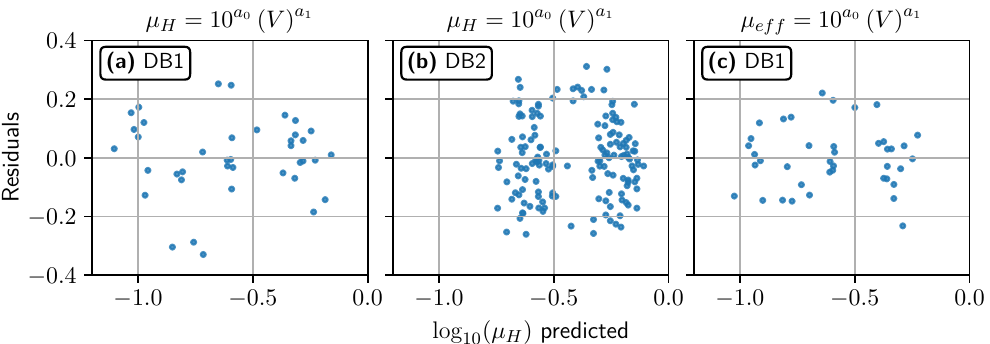
Figure A1. Residuals VS predicted values for the different power laws deduced from empirical databases. The axis scale is logarithmic. ( a ) µ H = µ 1 ( V ) , with DB1 . ( c ) µ H = µ 2 ef f